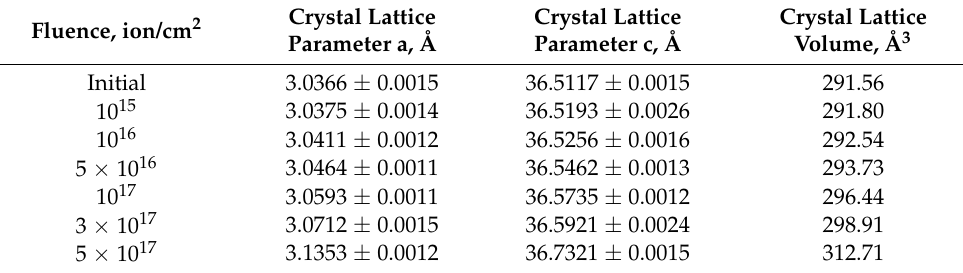
Table 2. Crystal lattice parameter